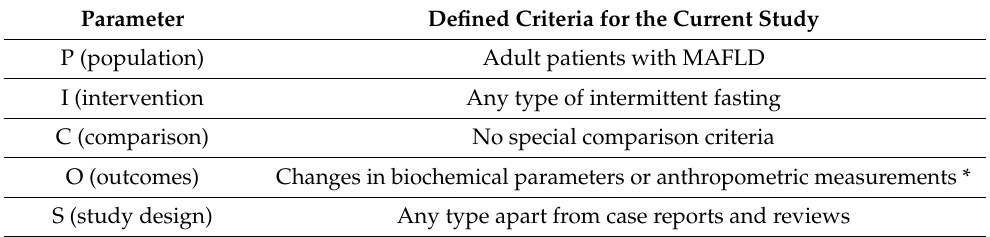
Table 1. PICOS criteria for inclusion and exclusion of studies. Parameter Defined Criteria for the Current Study Adult patients with MAFLD Any type of intermittent fasting No special comparison criteria Changes in biochemical parameters or anthropometric measurements